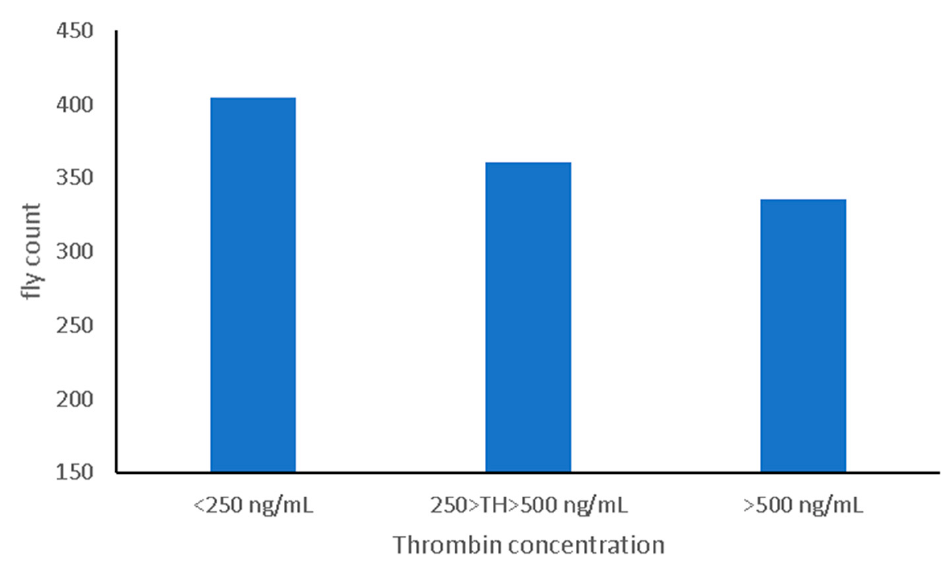
Figure 4. Average fly count across the three thrombin classes.